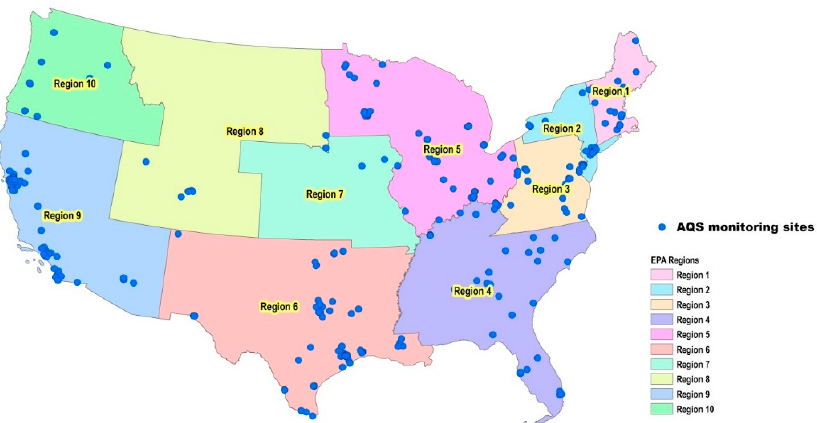
Figure 1. Air toxics monitoring sites archived in the U.S. Environmental Protection Agency (EPA)’s Air Quality System (AQS).